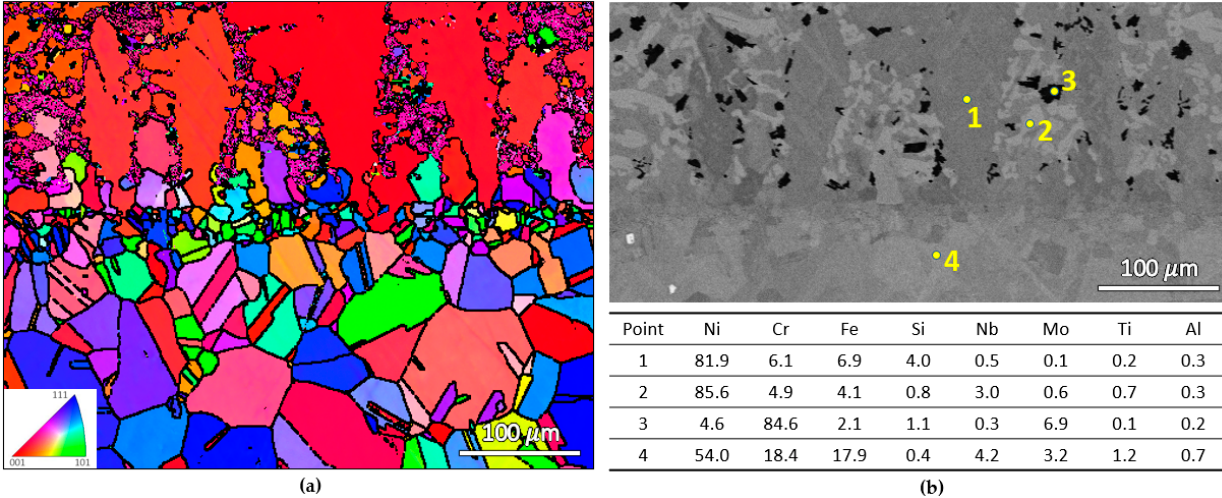
Figure 6. Interface of specimen S2 (1050 °C for 2 min): ( a ) EBSD inverse pole figure (IPF-Y) map; ( b ) Backscatter electron micrograph showing different phases in the brazed layer (points 1, 2 and 3) and in the substrate (point 4) and their chemical composition (wt.%) measured by EDS.